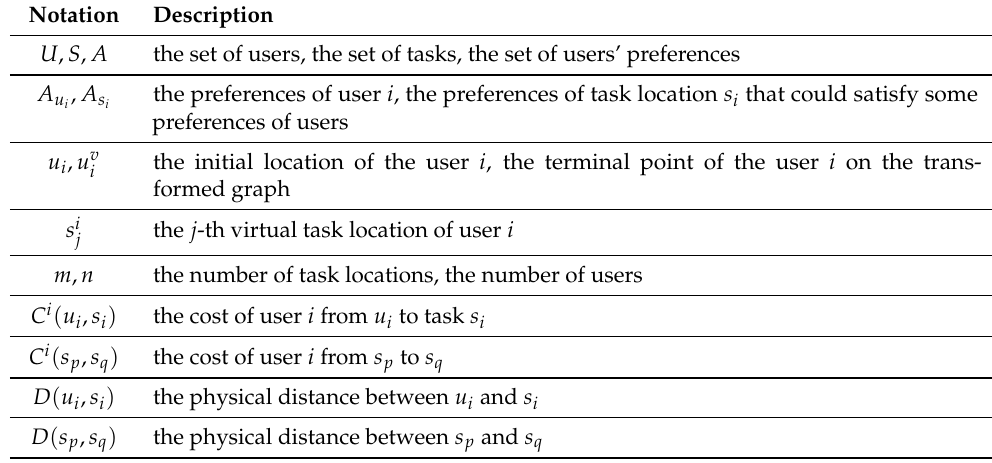
Table 1. List of key